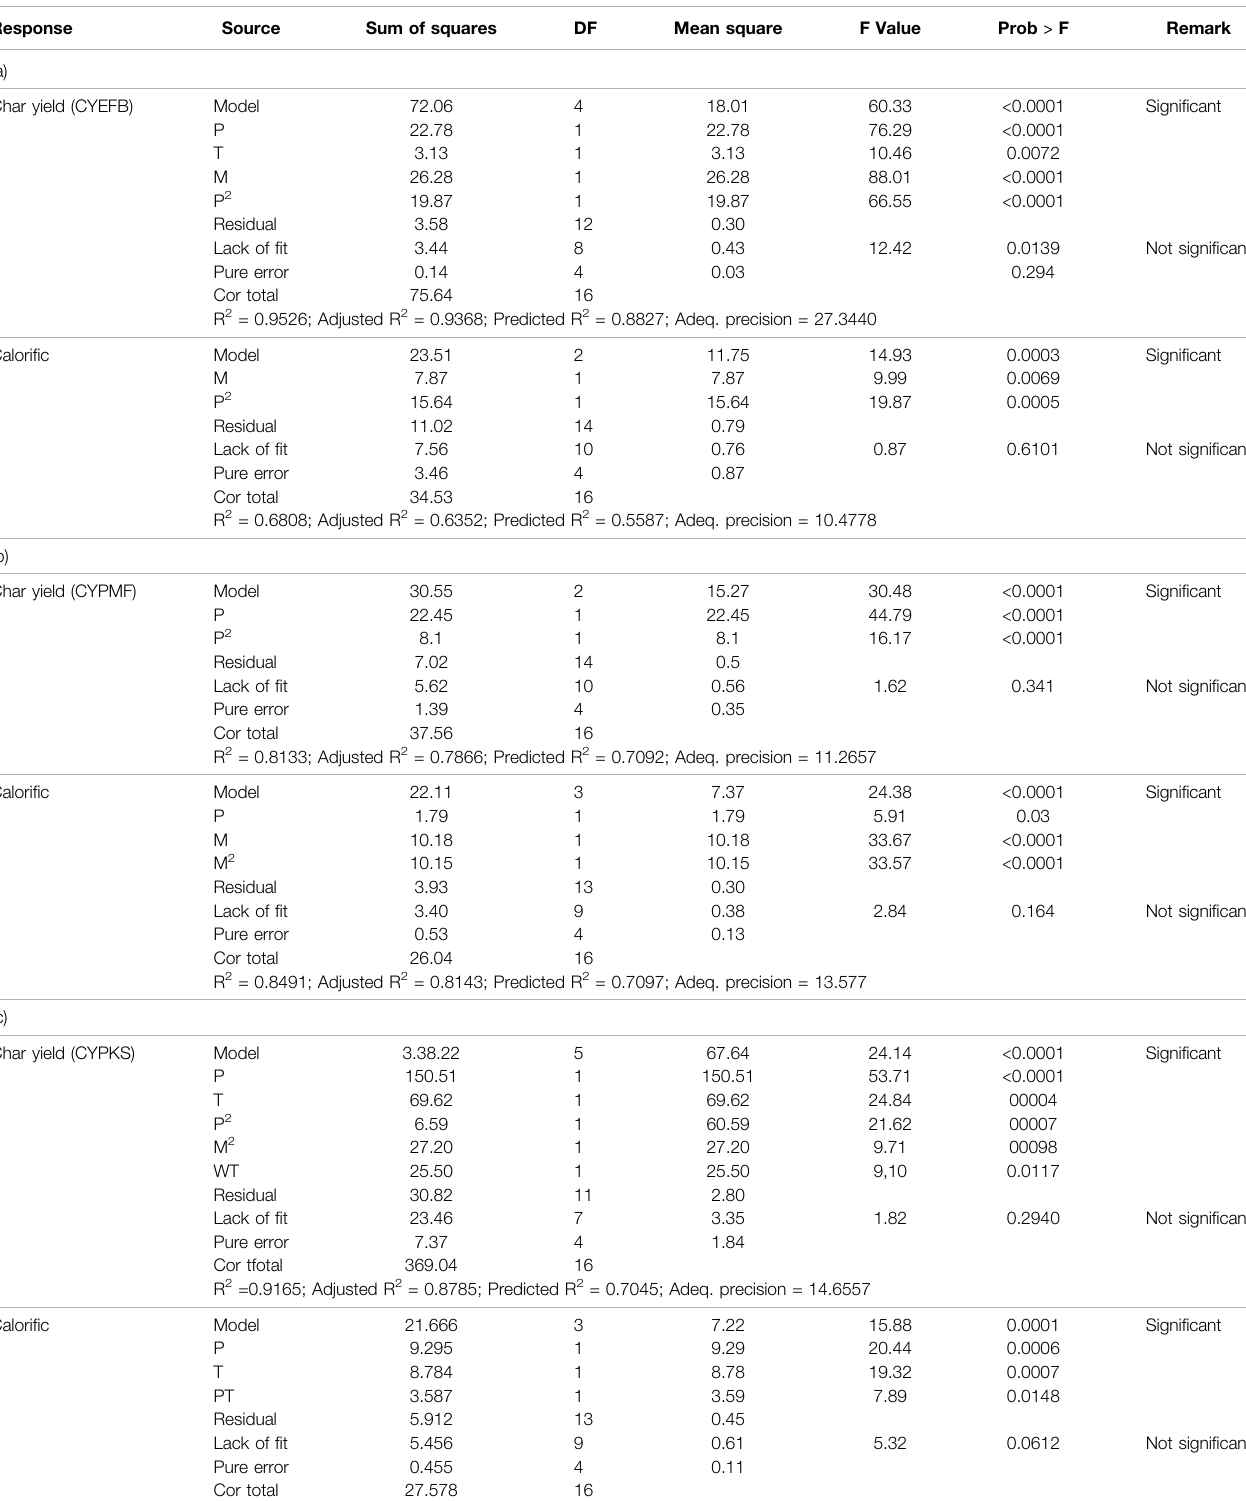
TABLE 6 | ANOVA analysis for DOE of MW pyrolysis of (a) EFB, (b) PMF, and (c) PKS, for response of char yield and calori fi c value.